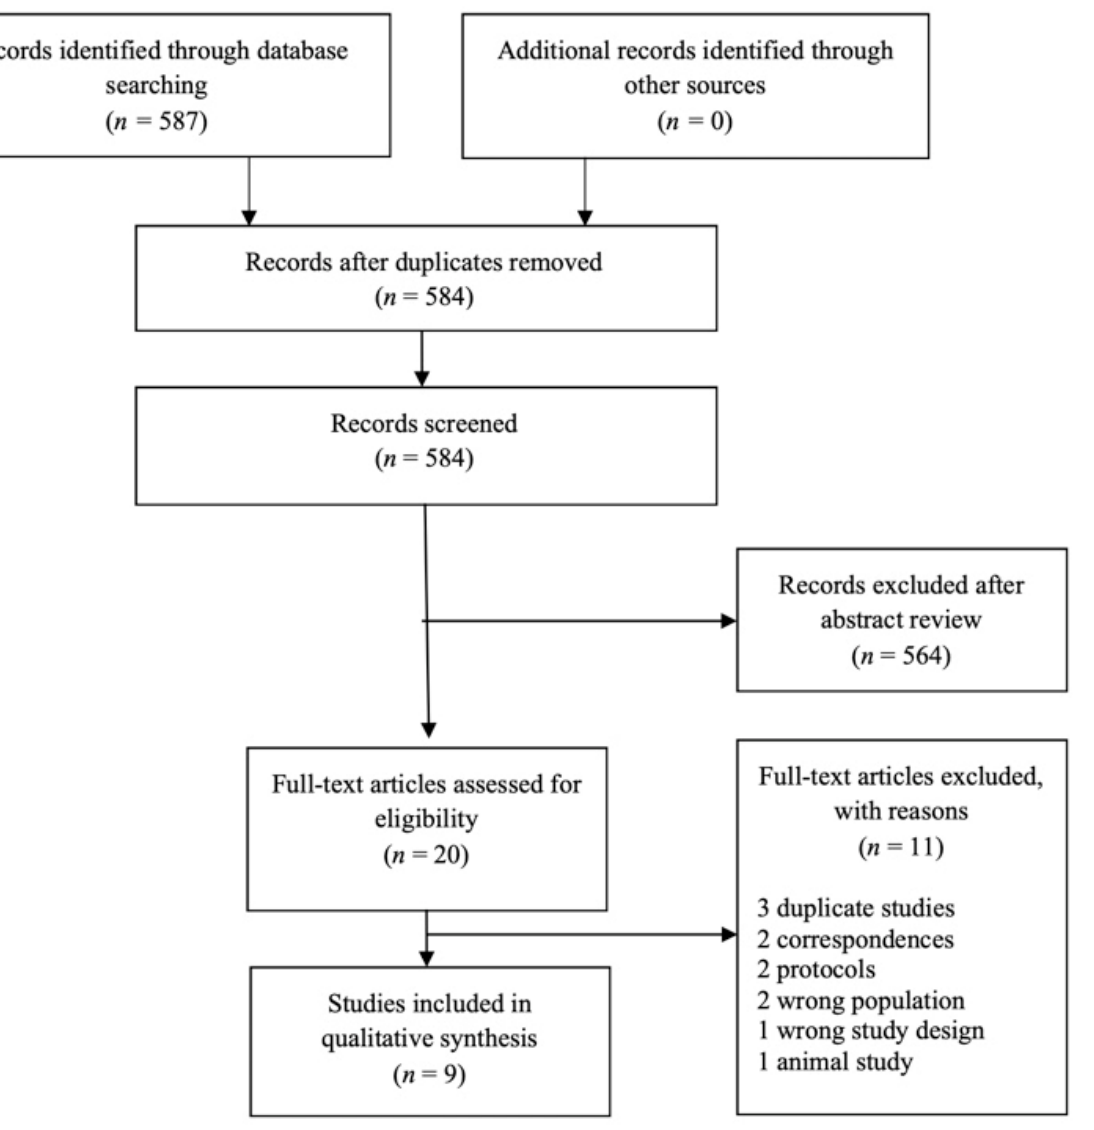
Figure 1. Study selection process.